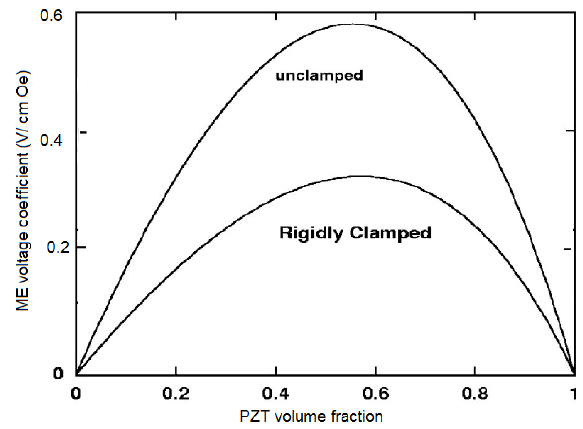
Figure 12. PZT volume fraction dependence of ME voltage coefficient for free and rigidly clamped bilayers of NZFO and PZT for transverse fields‘